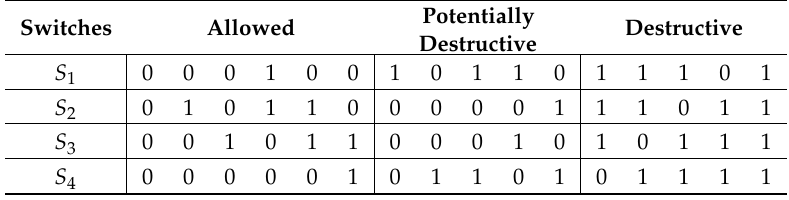
Figure 5. Comparison of basic configurations: ( a ) 3L-NPC and ( b ) 3L-ANPC. Table 4. Switching states